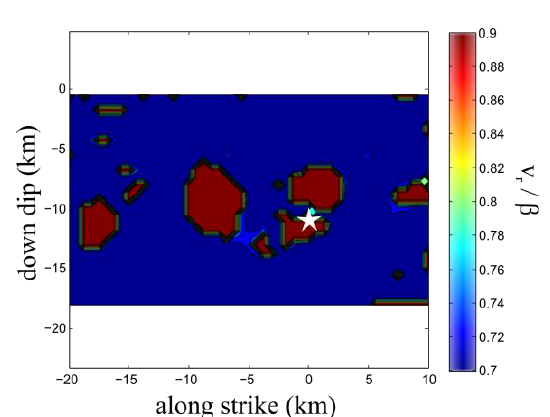
Figure 2: Along strike and down dip distribution of the Mach number=Vr/β. The hypocenter posi- tion is indicated with a star.